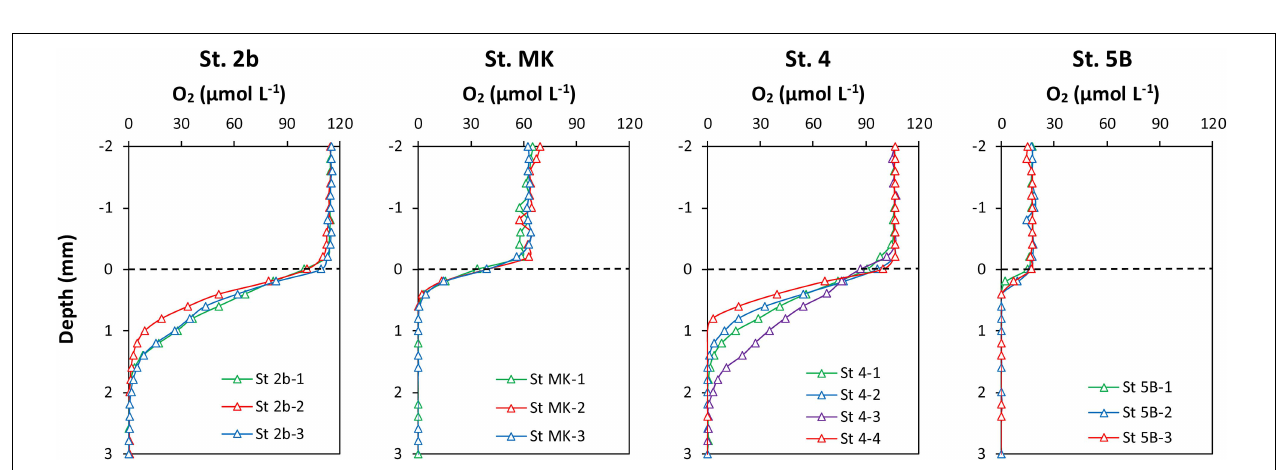
Frontiers in Marine Science |